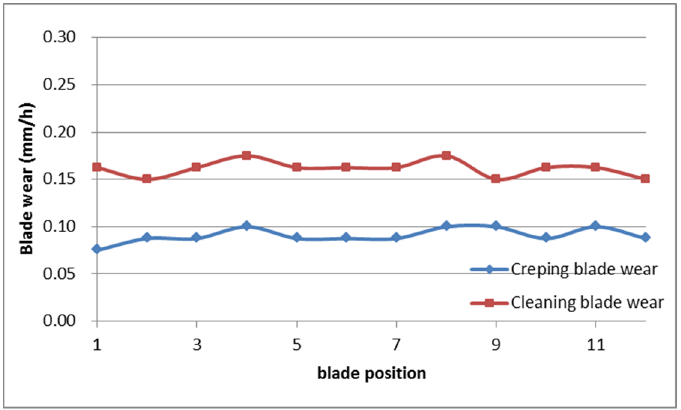
Figure 7. Creping and cleaning blade wear as a function of time.